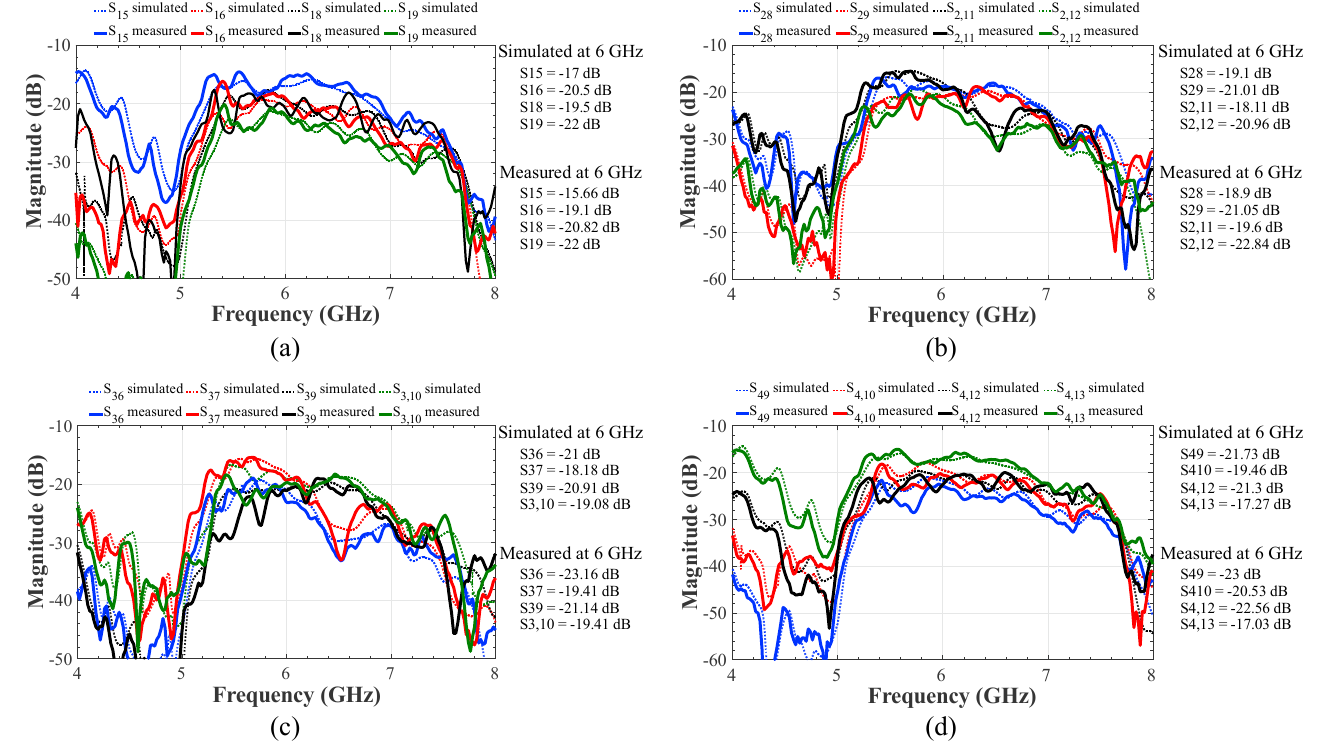
Figure 8. Transmission coefficients simulated and measured experimentally for the proposed feeding system (of 4 × 9 CORPS network) for each input port: ( a ) P1, ( b ) P2, ( c ) P3 and ( d ) P4. The proposed feeding system using the linear phased array generates a reduction of phase shifters, providing a maximum SLL of approximately − 22 dB for the range of θ 0 = ± 25 ◦ . The SLL performance ( − 22 dB) is maintained during beam-scanning in θ 0 = ± 25 ◦